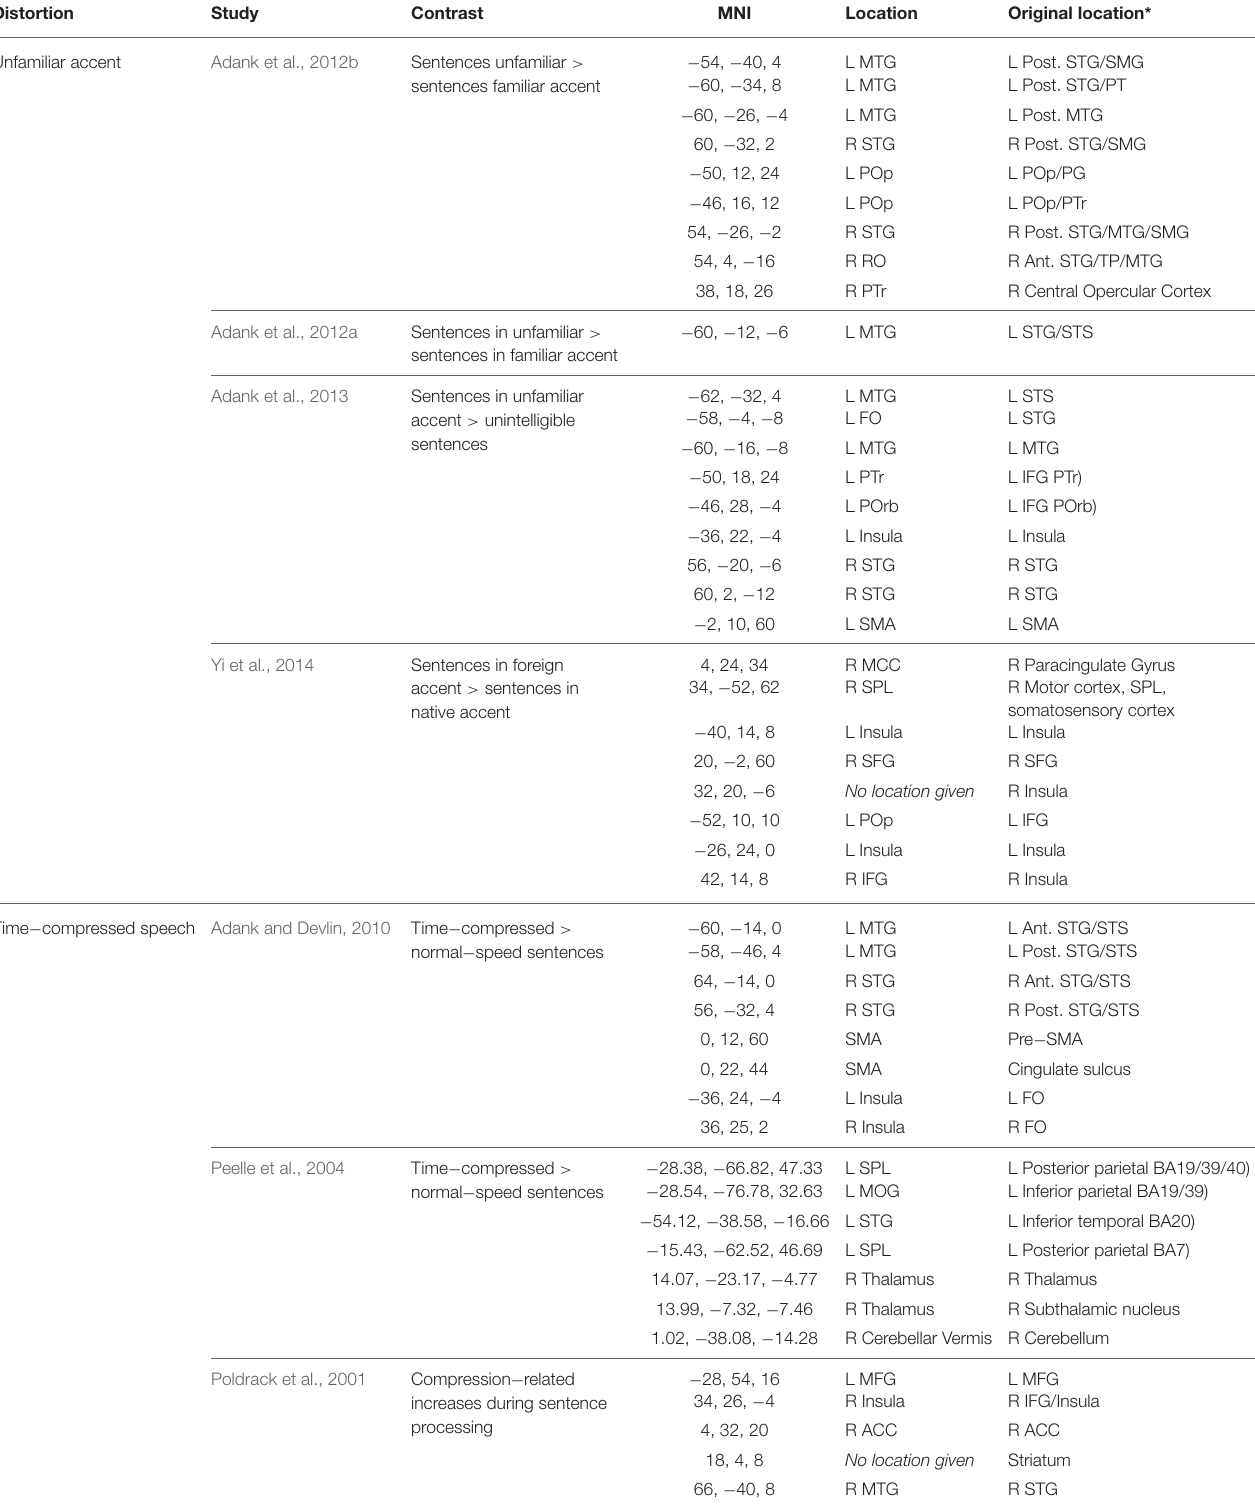
TABLE 1 | Reported brain regions in studies investigating processing of accented, time-compressed, or noise-vocoded speech, plus speech with added background noise vs. undistorted words or sentences. Distortion Study Contrast MNI Location Original location * Unfamiliar